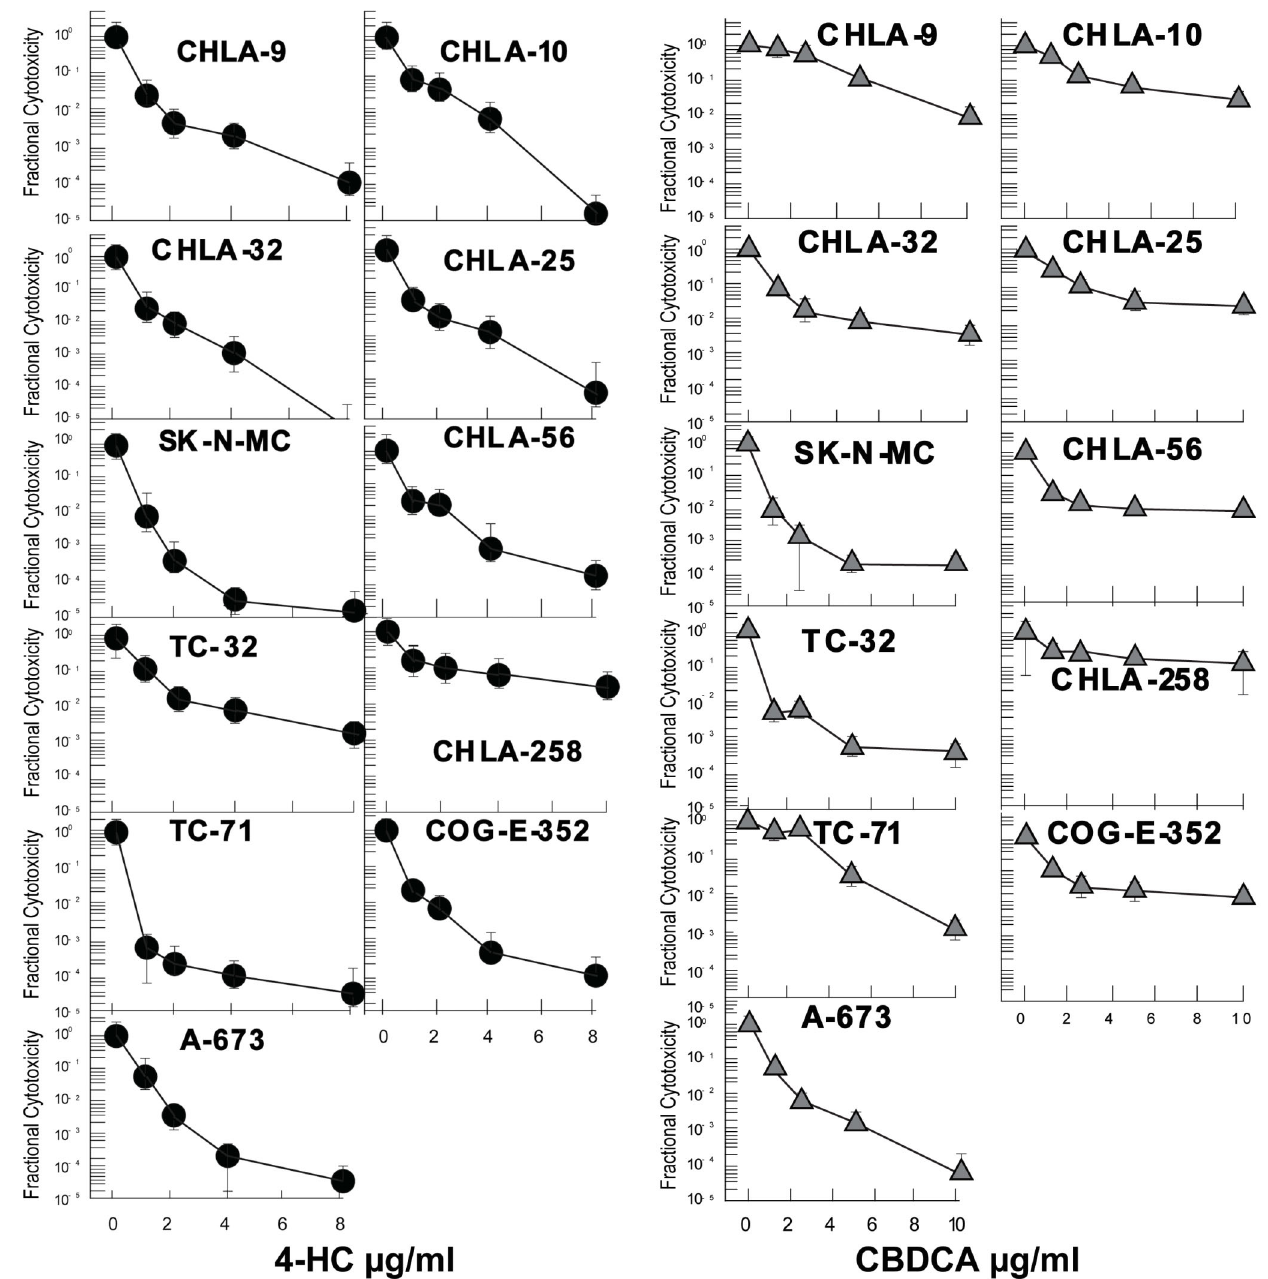
Figure 3. The EFT cell lines treated with chemotherapeutic agents. X-axis is drug concentration. The y-axis shows Fractional Cytotoxicity. 4- hydroperoxycyclophosphamide (4-HC: 0–8 m g/ml) and carboplatin (CBDCA: 0–10 m g/ml). Points represent the means 6